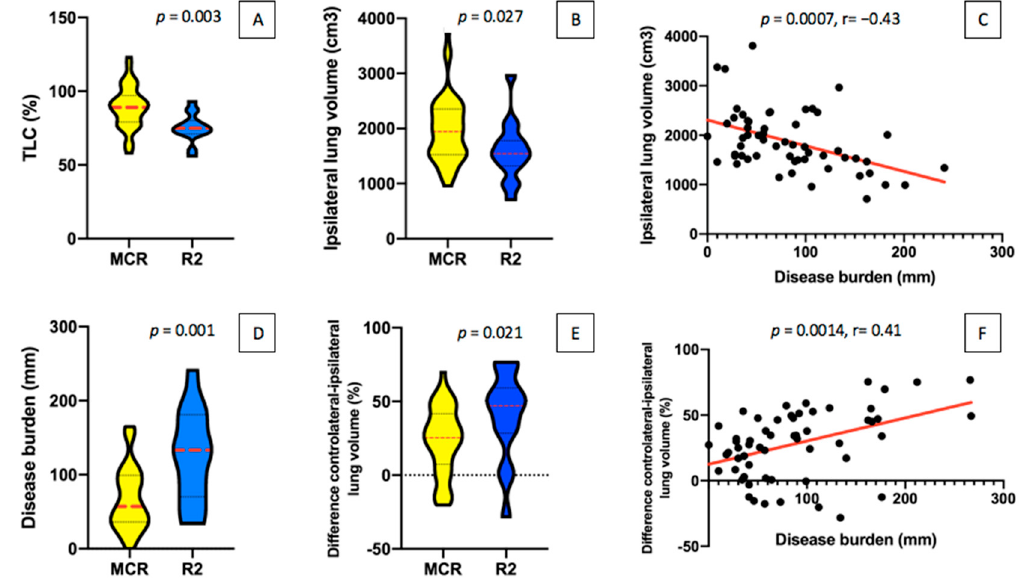
Figure 2. Comparison of between resectable (MCR) and unresectable (R2) cohorts in TLC% ( A ), ipsilateral lung volume ( B ), disease burden ( D ), and difference in contralateral and ipsilateral lung volume ( E ). Correlation between the increase of disease burden with both the decrease of the ipsilateral pathological lung volume ( C ) and the increase of the difference between the contralateral and the ipsilateral pathological lung ( F ). TLC: total lung capacity.